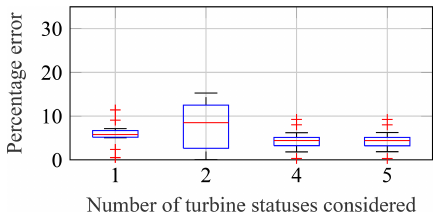
Figure 17. Percentage errors of predicted yearly damage values us- ing a binning method (1D wind speed bins) compared to real yearly damage values. Data separated according to different turbine sta- tuses (cf. Fig. 16).